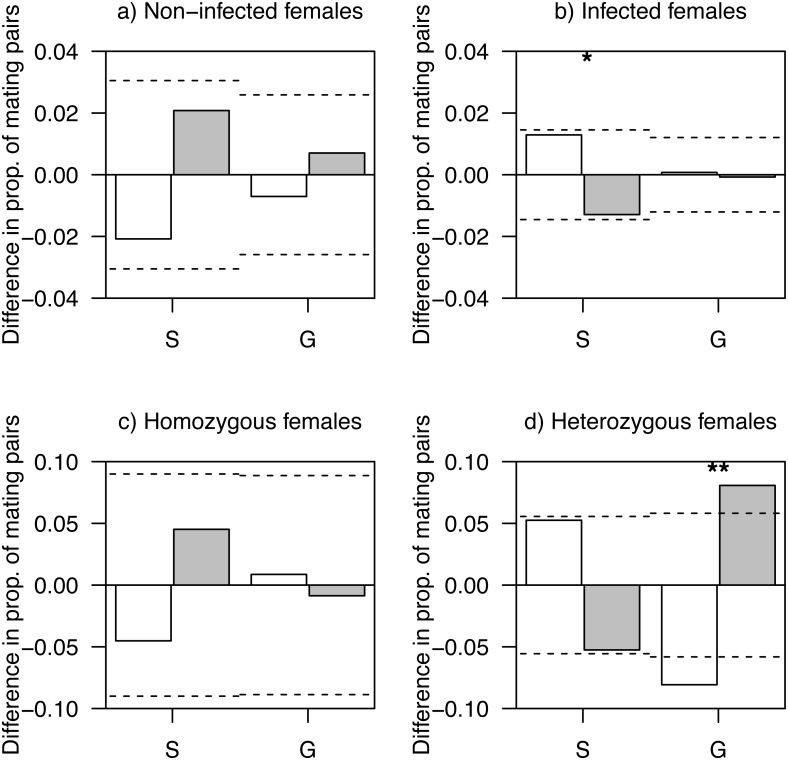
Difference in proportions of observed and expected mating pairs.(A) Females non-infected by haemosporidian parasites, (B) infected females, (C) homozygous females at AvBD2 locus and (D) heterozygous females at AvBD2, paired with either social (S) or genetic males (G). White bars represent non-infected (A, B) or homozygote (C, D) males, and grey bars, infected (A, B) or heterozygote (C, D) males. P-values (*P < 0.1; **P < 0.05) are shown. Significance threshold (P < 0.05) in each case is represented by a dashed line.